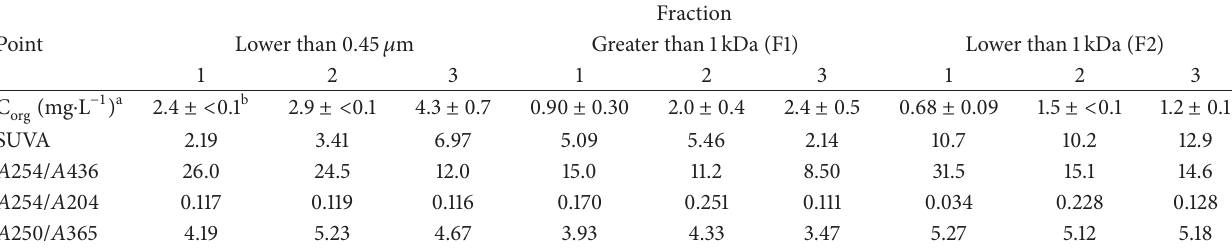
Table 2: Characterization of DOM fractions by UV-Vis spectroscopy and organic carbon content.